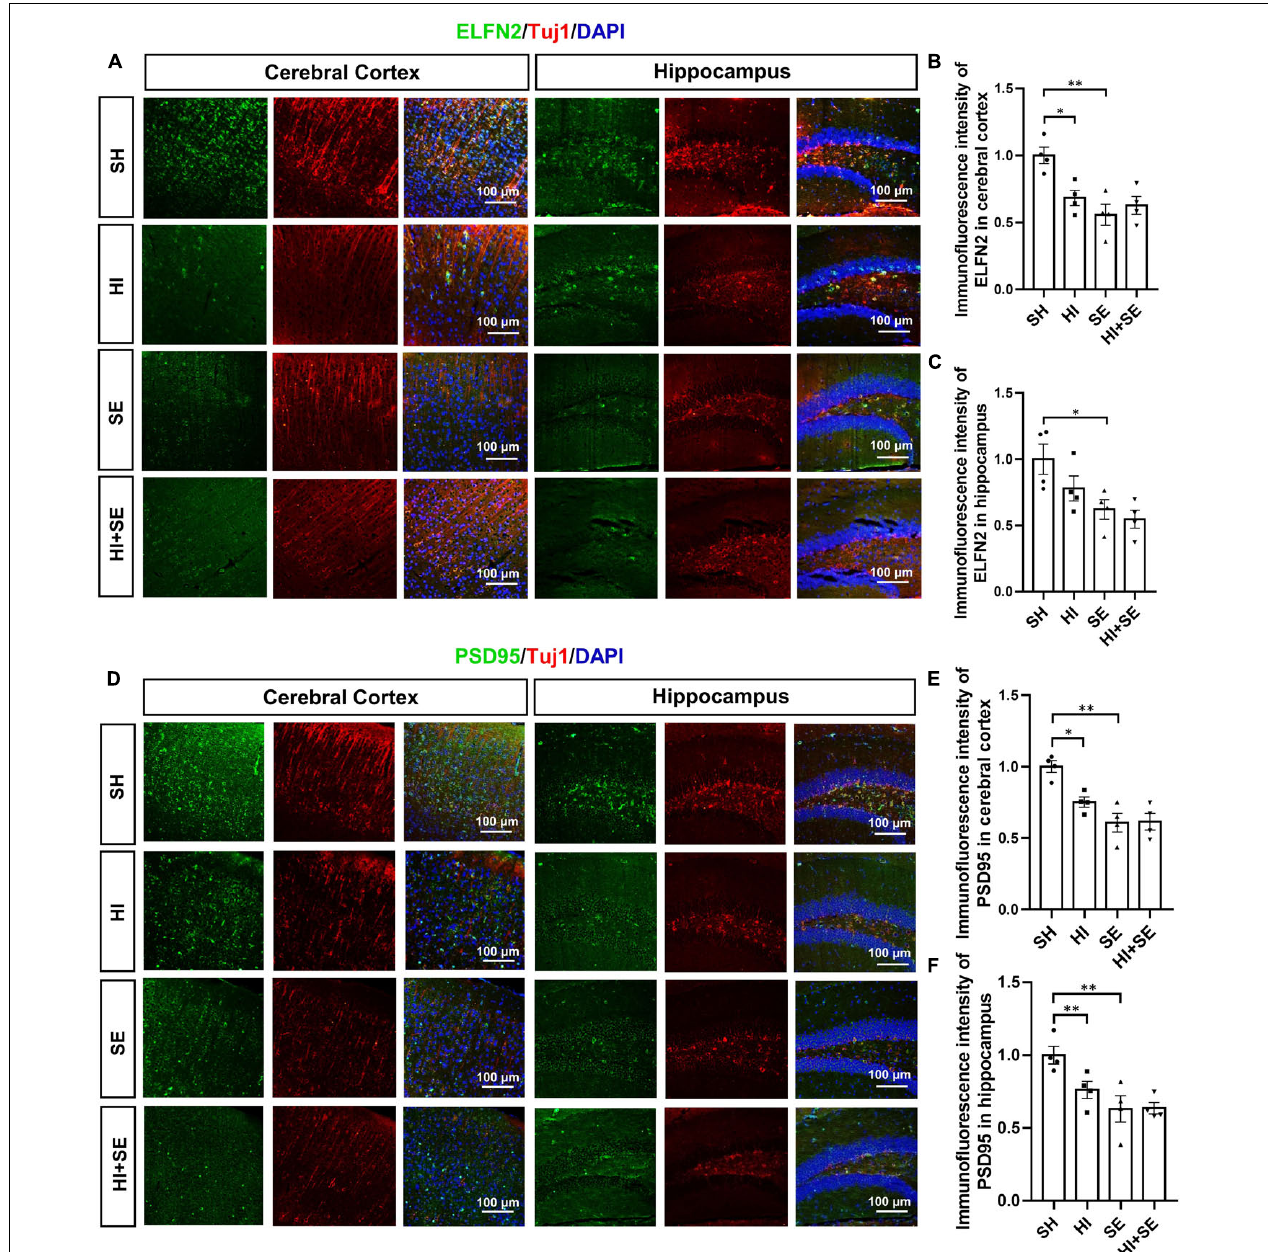
FIGURE 3 | HI injury and maternal SE led to synaptic protein loss. Representative images of ELFN2 and Tuj1 immunofluorescence staining in the cerebral cortex and hippocampus (A) . The fluorescence intensity of ELFN2 in the cerebral cortex (B) and hippocampus (C) . Representative images of PSD95 and Tuj1 immunofluorescence staining in cerebral cortex and hippocampus (D) . The fluorescence intensity of PSD95 in the cerebral cortex (E) and hippocampus (F) . Results are presented as mean ± SEM. * P < 0.05, ** P < 0.01, n = 4, analyzed by two-way ANOVA followed by post hoc Turkey tests. SH, from sham exposed dams with sham surgery; HI, hypoxic-ischemic injury; SE, from smoke exposed dams with sham surgery; HI + SE, from smoke exposed dams with hypoxic-ischemic